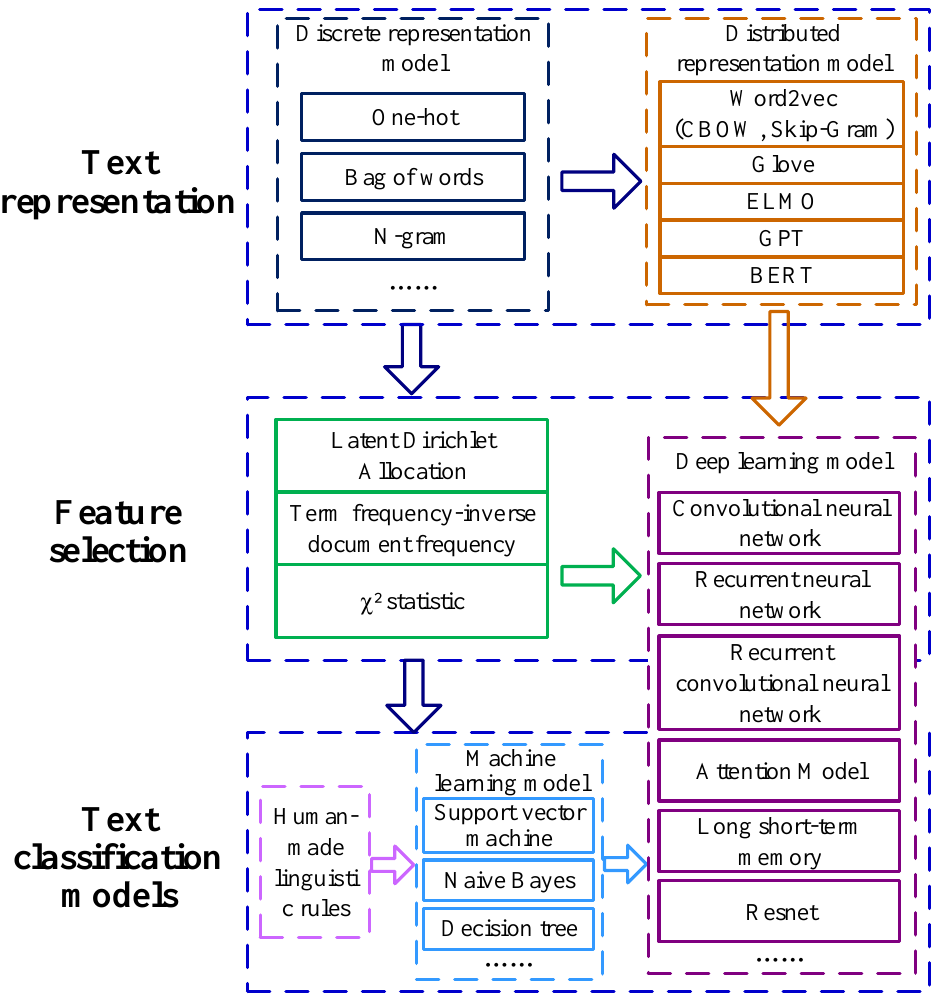
Figure 2. Development process of text